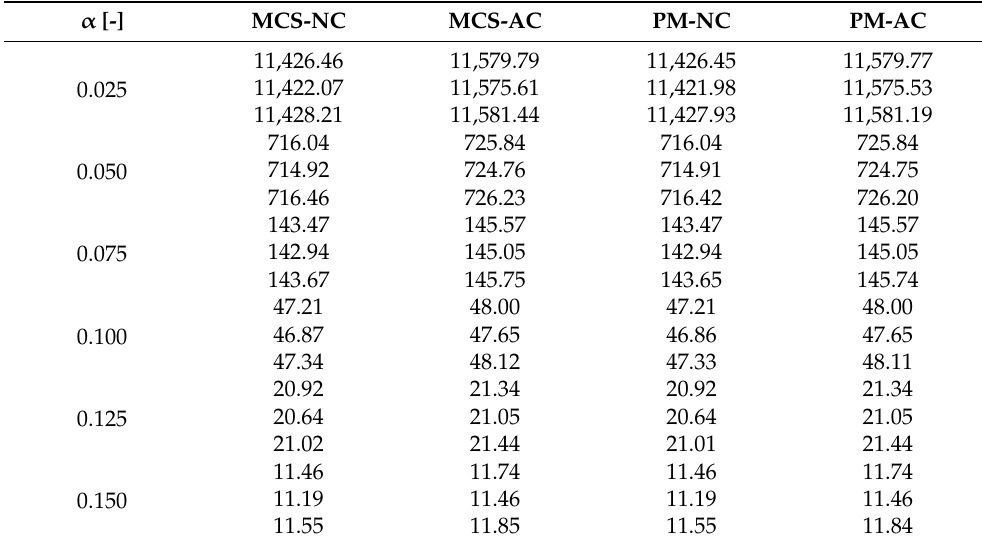
Table 5. A contrast of the estimated reliability indices β (cid:48) in the SLS by numerical and analytical methods based upon the Monte Carlo simulation method and the stochastic perturbation technique for the triangular, uniform and Gaussian probability distributions.